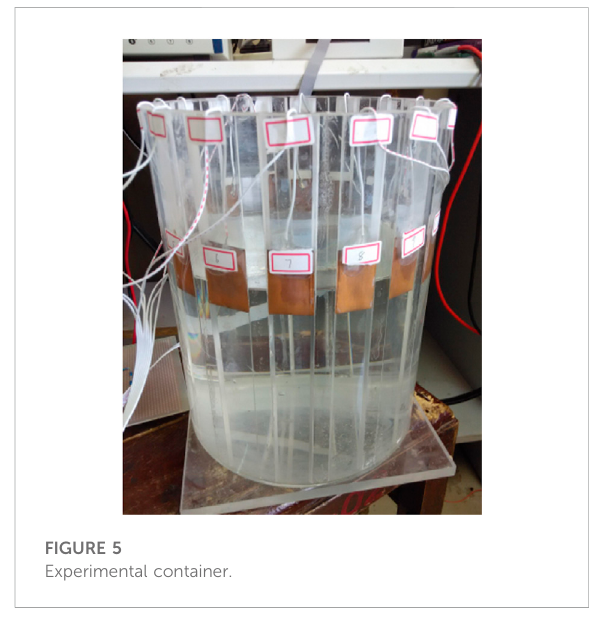
FIGURE 5 Experimental container.